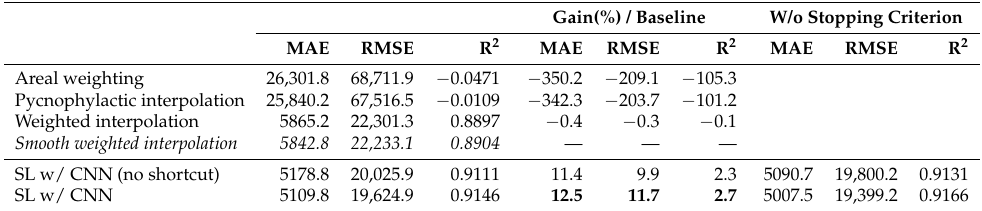
Table 6. Results obtained with different disaggregation methods for the amount of national with- drawals during the winter months.